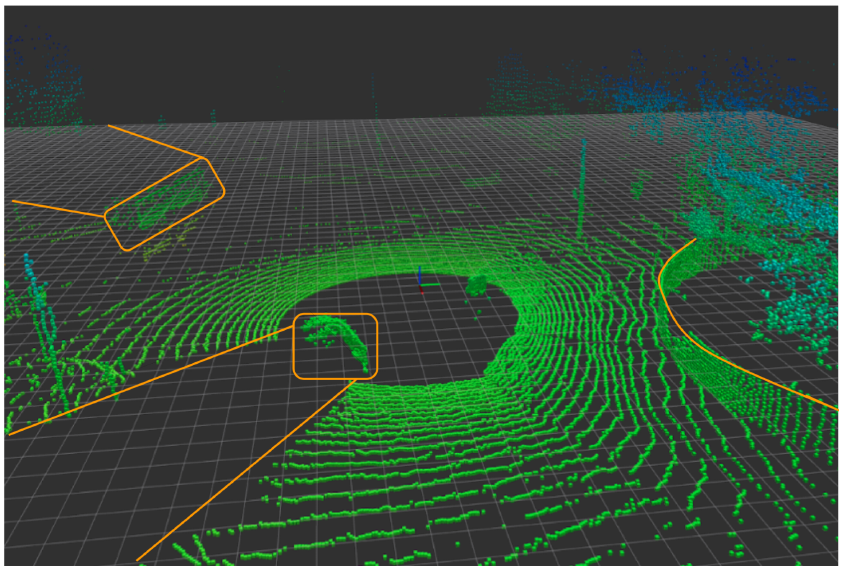
Figure 21. LiDAR point cloud occlusion from nearby vehicles. Three occlusions can be seen outlined with the orange lines, car, bus, and